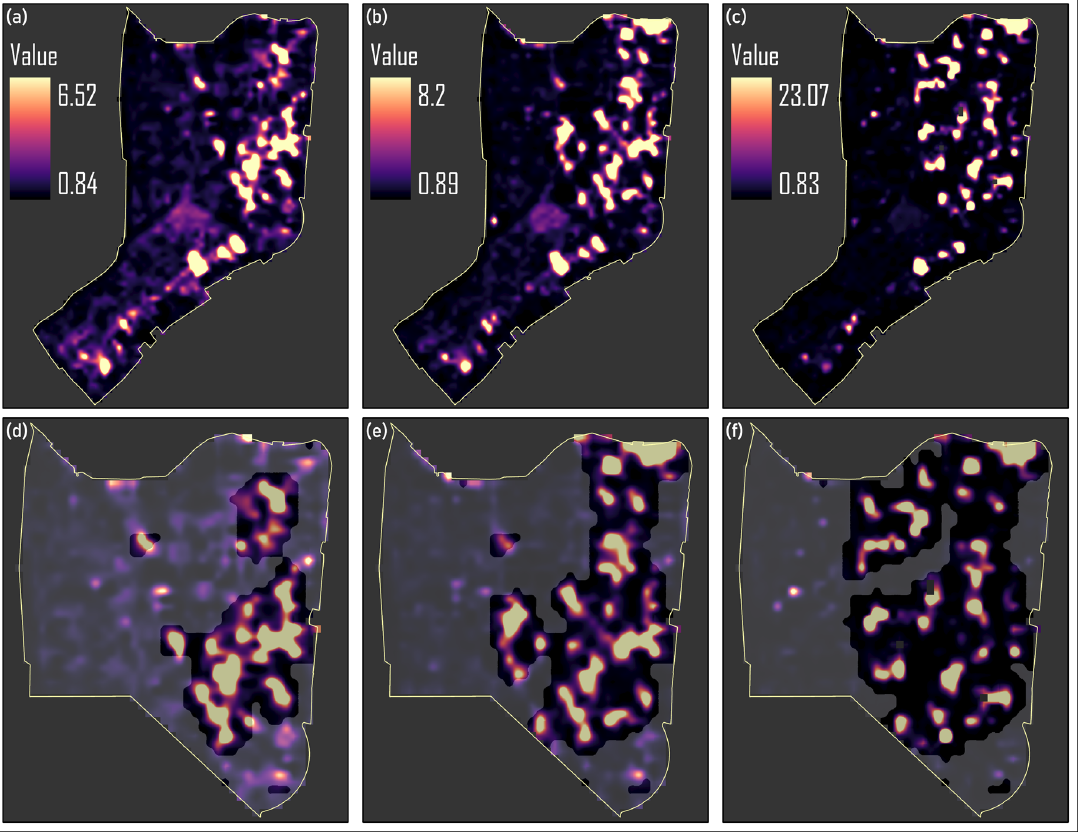
Figure 11. BAEI (as a shadow index) change detection time-series of the Brickell neighborhood derived from Landsat data; ( a ) 5 TM 11/20/03, ( b ) 11/17/08, ( c ) 8 OLI 10/22/16. The area of interest overlaid with a focalized classification (transparent) based on thresholding; ( d ) 5 TM 11/20/03. ( e ) 11/17/08. ( f ) 8 OLI 10/22/16.